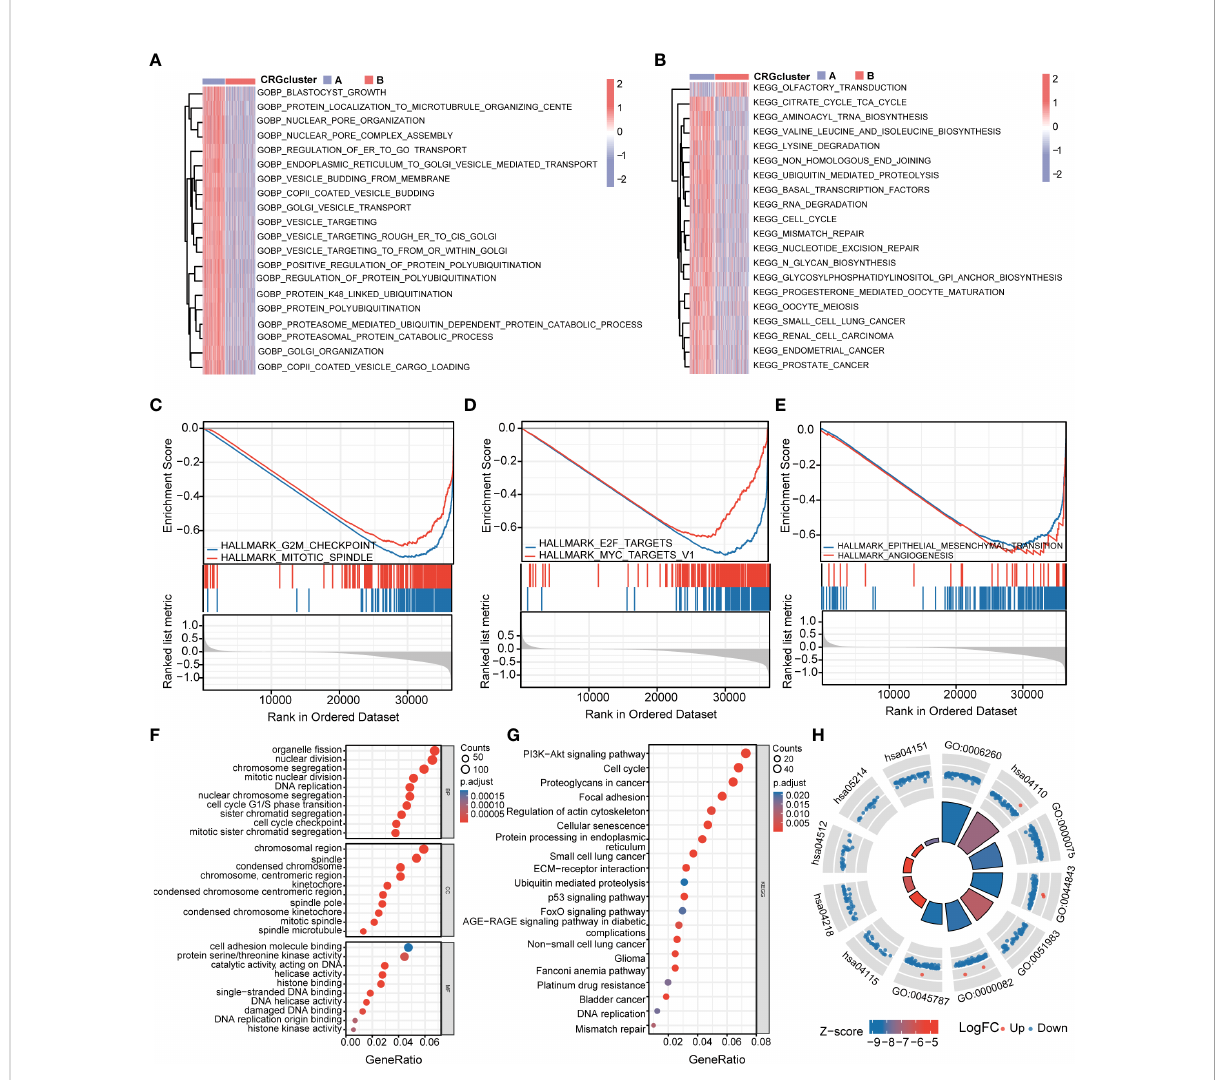
FIGURE 4 Functional enrichment analysis and identi fi cation of differentially expressed genes (DEGs) between CRG clusters. (A) Gene set variation analysis (GSVA) of gene ontology biological process (GOBP) terms between CRG cluster A and B, in which red and blue represent activated and inhibited, respectively. (B) GSVA of Kyoto Encyclopedia of Genes and Genomes (KEGG) terms between CRG cluster A and B, in which red and blue represent activated and inhibited, respectively. (C-E) Gene set enrichment analysis (GSEA) of signi fi cant HALLMARK enriched in CRG cluster (A) (F – H) GO and KEGG enrichment analyses of DEGs between two CRG clusters. DEGs, differentially expressed genes; GSVA, gene set variation analysis; GOBP, gene ontology biological process; GSEA, gene set enrichment analysis; GO, Gene Ontology; KEGG, Kyoto Encyclopedia of Genes and